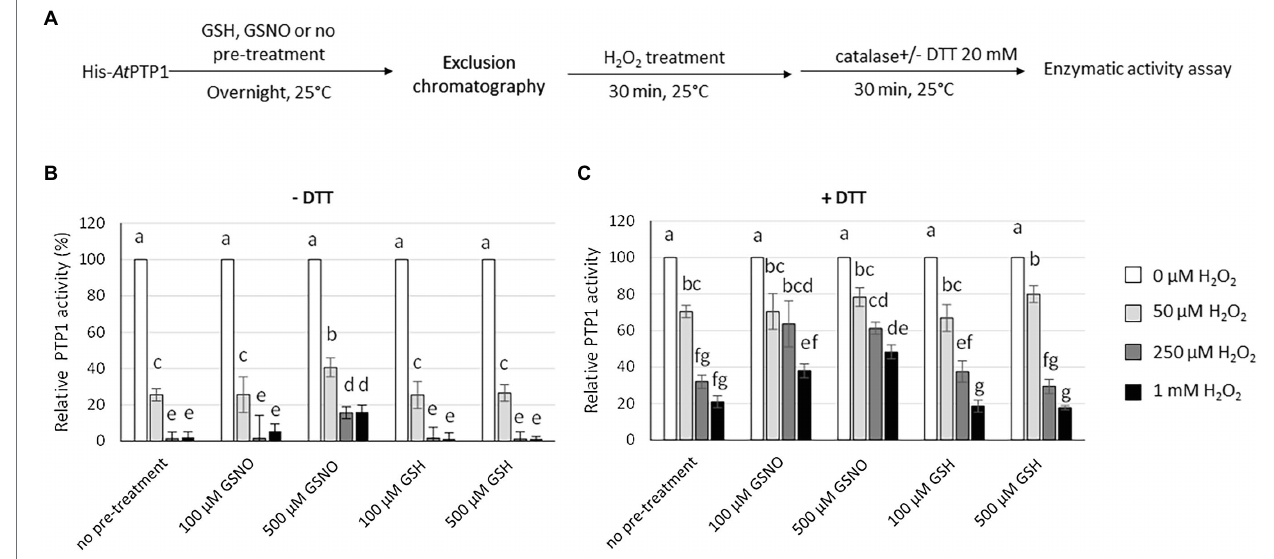
FIGURE 5 | Effect of H 2 O 2 treatment on His- At PTP1 activity in the absence or presence of DTT following pre-treatment with GSH or GSNO. (A) Experimental design. (B) Measurement of the enzymatic rate of His- At PTP1 following treatment with 50 and 250 μ M or 1 mM of H 2 O 2 in the absence of 20 mM DTT after pre- treatment with 100 or 500 μ M of GSH or GSNO. (C) Measurement of the enzymatic rate of His- At PTP1 following treatment with 50 μ M, 250 μ M or 1 mM of H 2 O 2 in the presence of 20 mM DTT after pre-treatment with 100 or 500 μ M of GSH or GSNO. Values are means of four measurements ±SEM. The results shown are from one representative experiment among three independent experiments. Significant differences are denoted by different letters ( p ≤